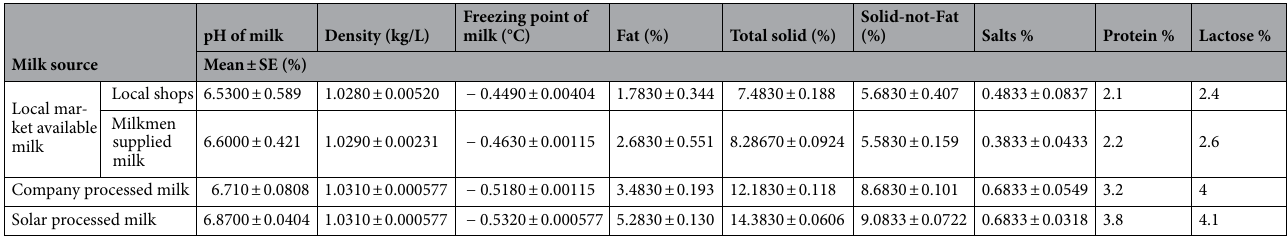
Table 2. Physical attributes of milk samples tested from local shops, milkmen, company-processed milk and solar-processed milk.